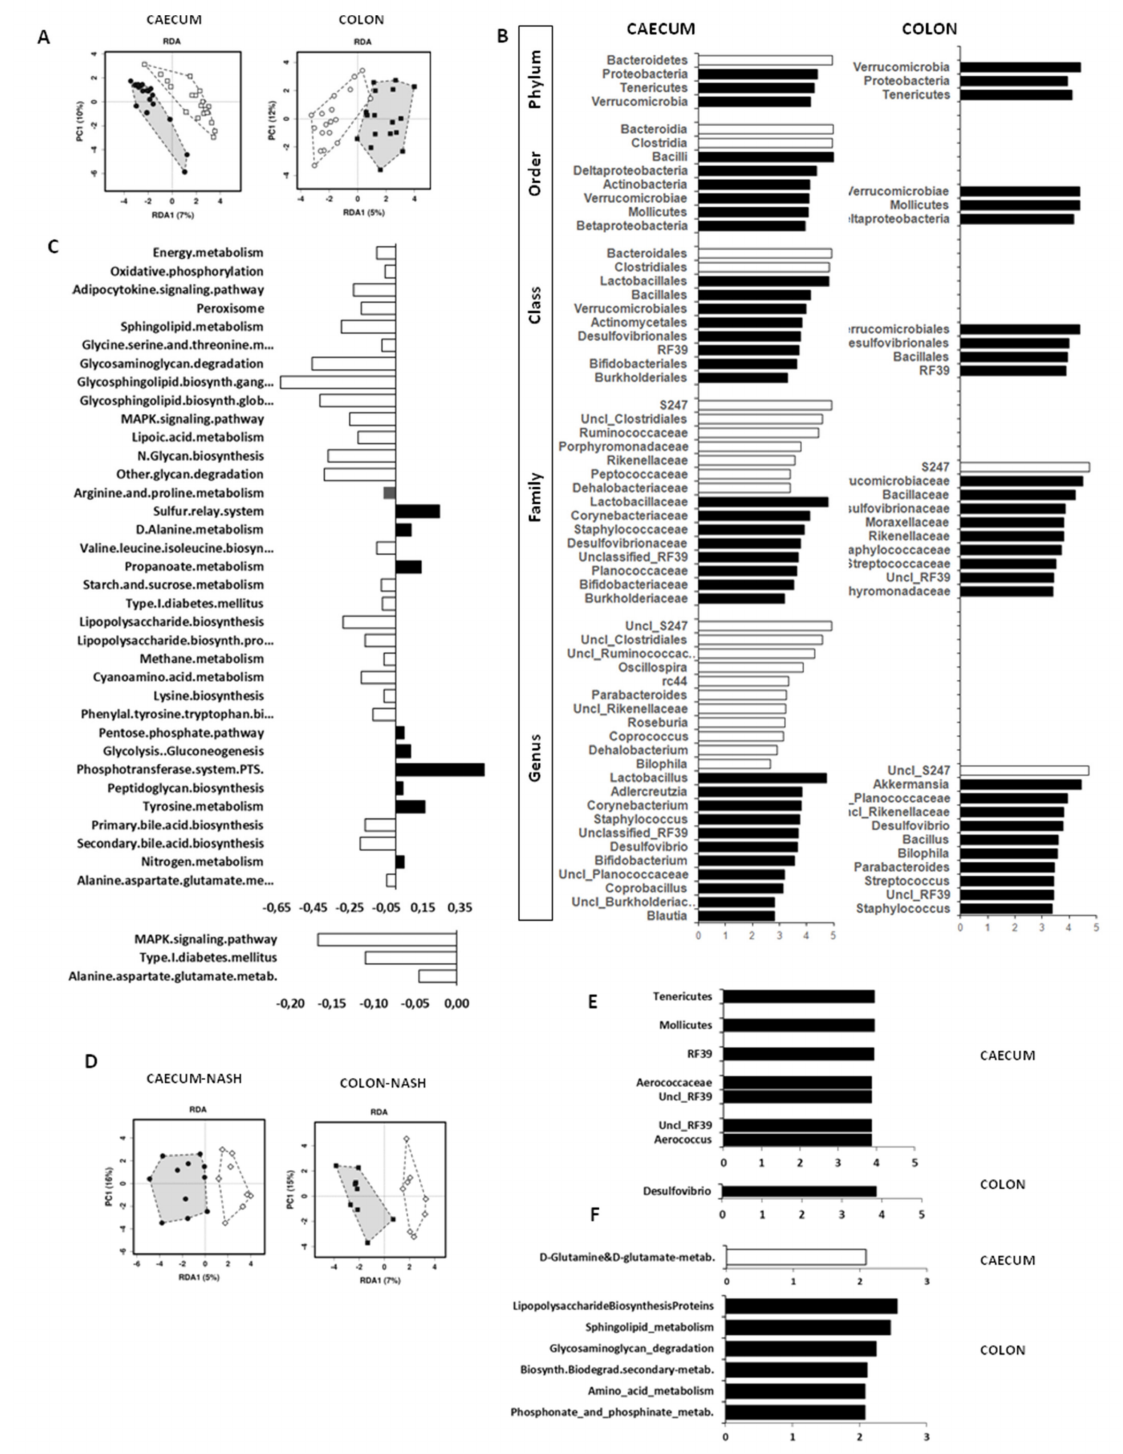
Figure 2. Significant differences in caecum and colon microbiota composition between weaning (white circles) and adult mice (black dots) are shown in RDA analysis ( A ), whereas LDA/LEFSe analyses ( B ) identify unique bacteria taxa biomarkers of weaning mice (white bars) and adult mice (black bars). Significant differences in metabolic pathways from KEGG analysis are expressed as ratios in panel ( C ), in which negative white bars indicate pathways prevailing at weaning, and positive black bars refer to pathways prevailing in adults. Panel ( D ) shows RDA analysis in animals stratified by the presence (black) or absence of NASH (white), and the corresponding significant unique biomarkers are given in panel ( E ) (bacteria taxa) and ( F ) (metabolic